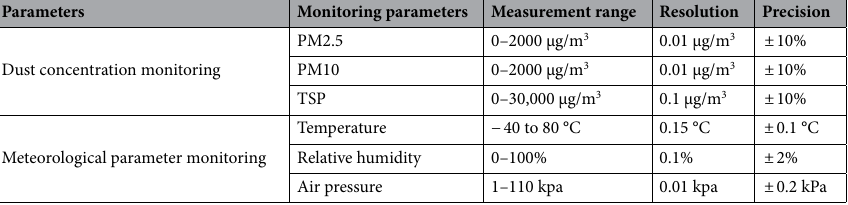
Table 2. Monitoring instrument module parameters.